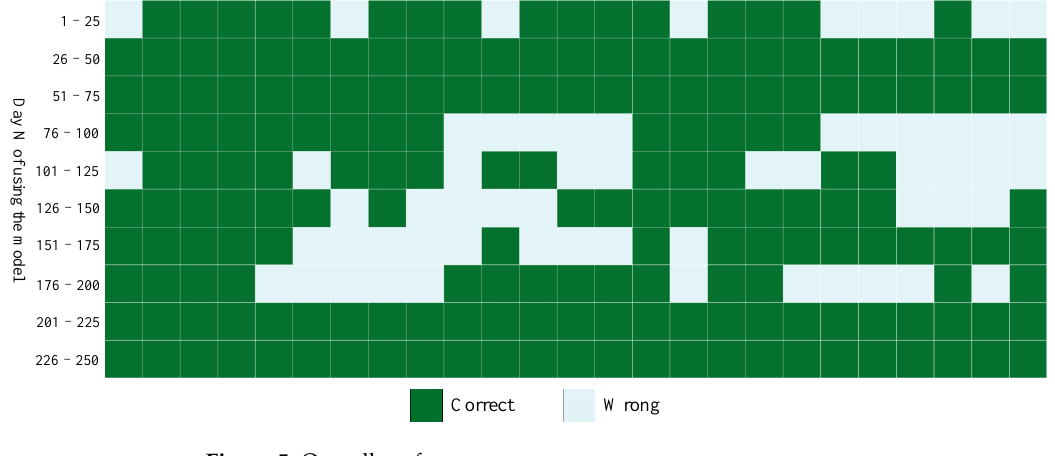
Figure 5. Overall performance.